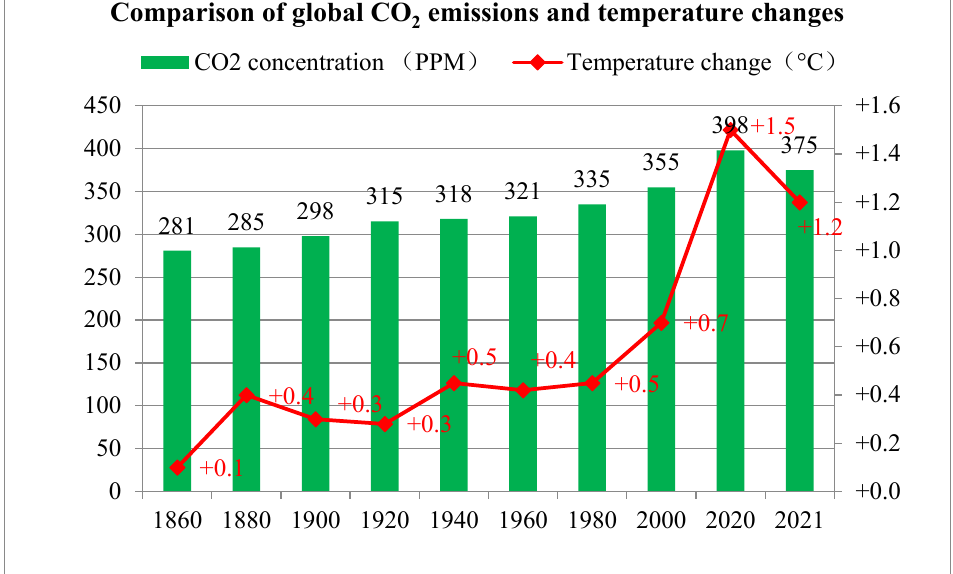
Figure 1. Comparison of global CO 2 emissions and temperature changes.